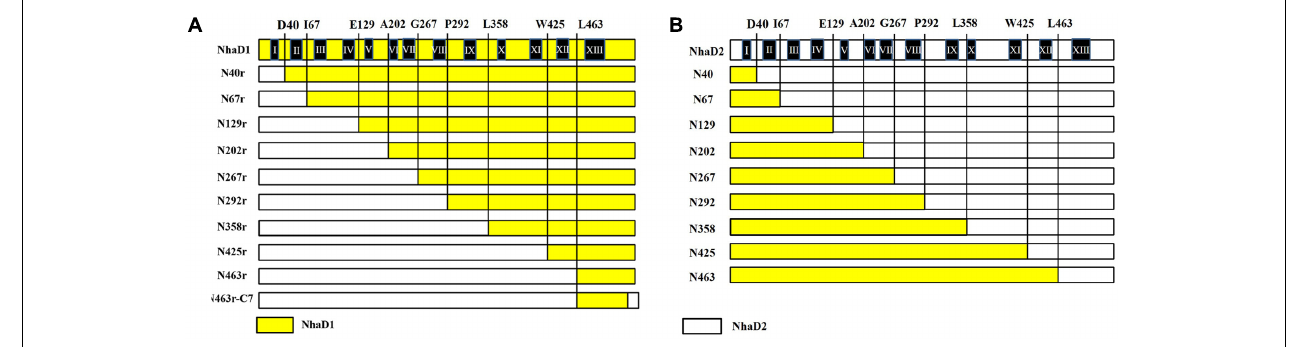
FIGURE 1 | Schematic representation of NhaD1 and NhaD2 chimeras. (A) NhaD1 chimeras that replaced N-terminal regions of NhaD1 with corresponding regions of NhaD2. (B) NhaD2 chimeras that replaced N-terminal regions of NhaD2 with corresponding regions of NhaD1. Regions from NhaD1 and NhaD2 are colored with yellow and white,